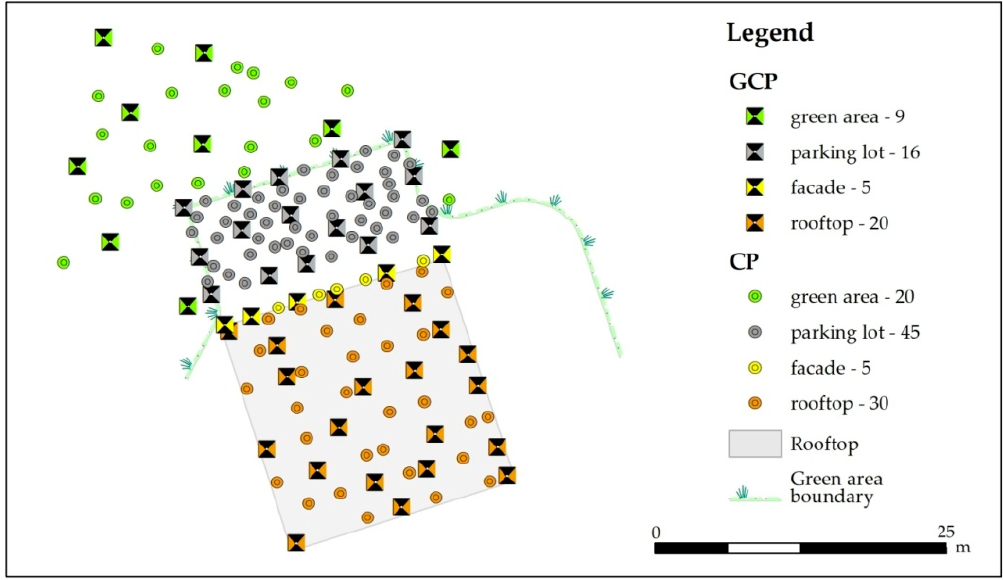
Figure 15. The 50 GCPs and 100 CPs distribution.